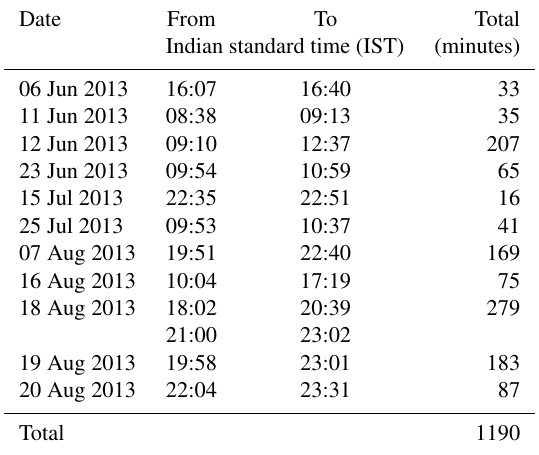
Table 1. Data sampling dates/periods used in this study during which no precipitation was